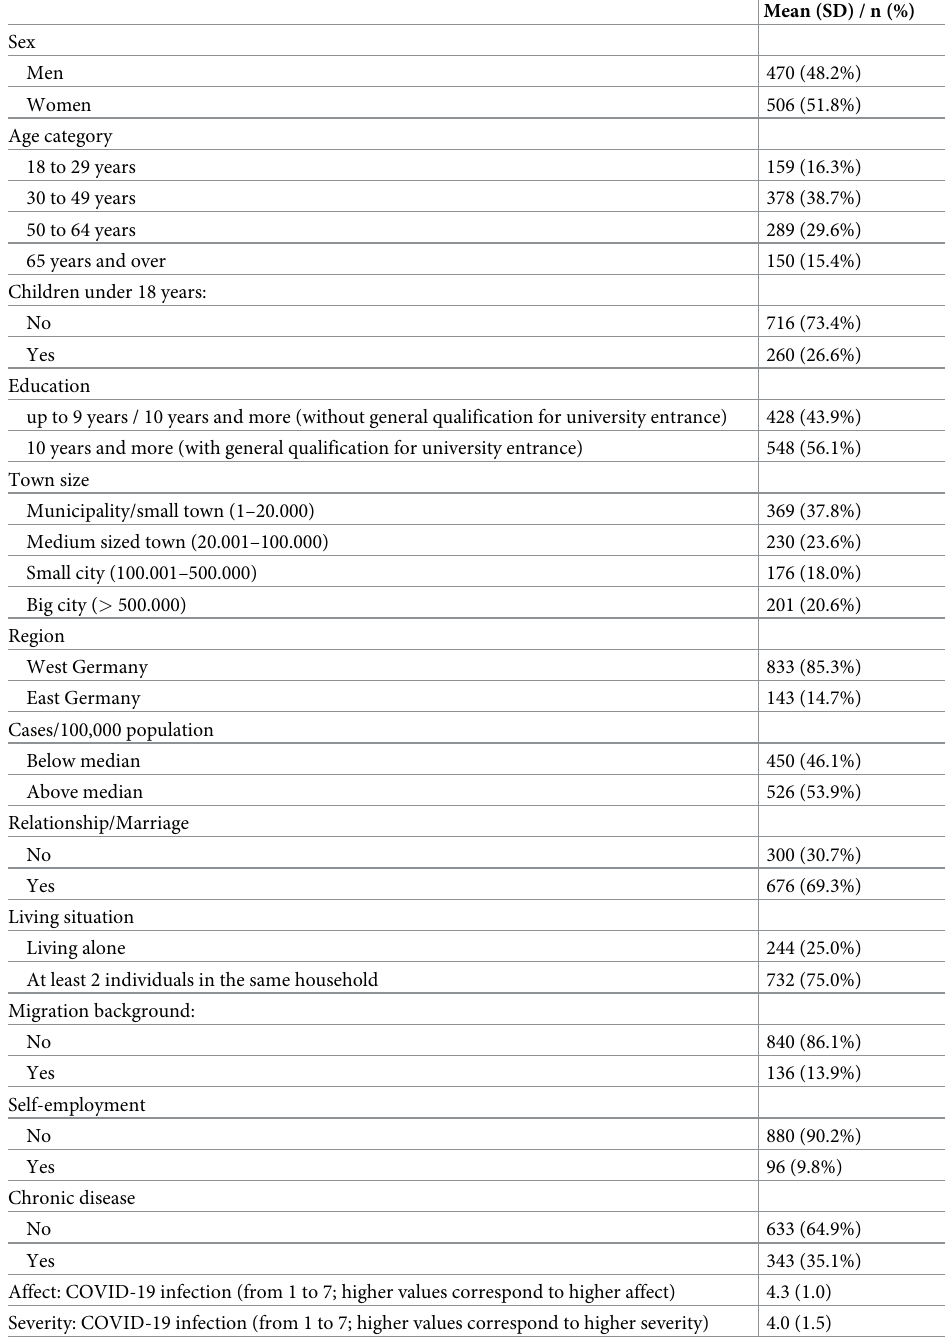
Table 1. Sample characteristics for the analytical sample (n = 976 individuals) at wave